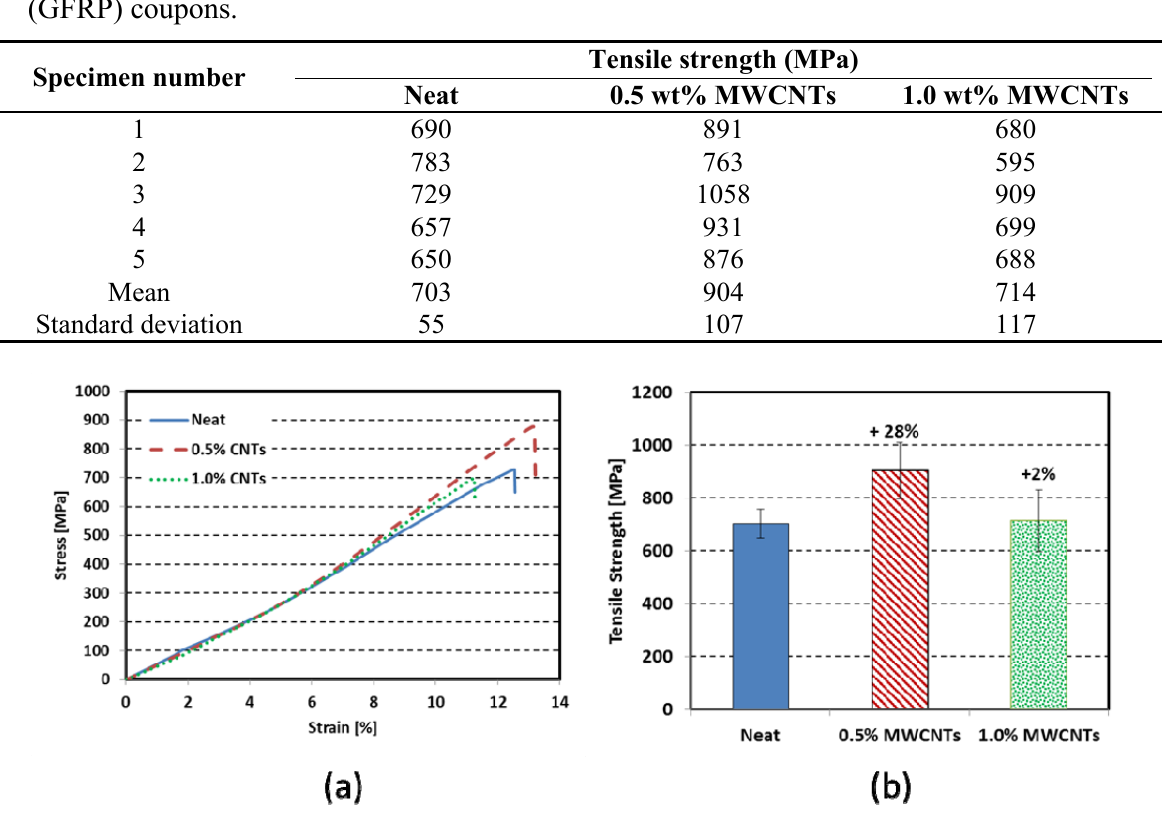
Figure 2. ( a ) Example median stress-strain curves for the neat, 0.5%, and 1.0% MWCNTs under static tension load; ( b ) maximum tensile strength for the neat, 0.5%, and 1.0% MWCNTs. % presented represent the improvement of the tensile strength of GFRP composites compared to reference